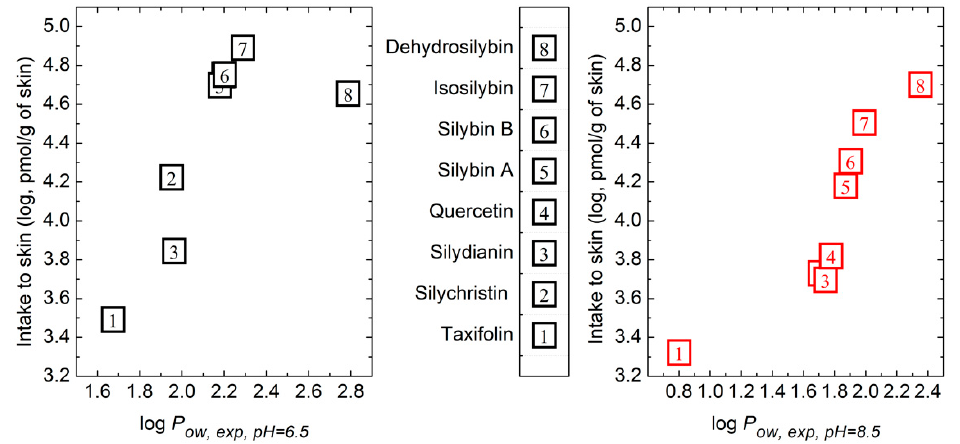
Figure 2. Relation of compounds’ skin intake to their lipophilicity. The relation of skin intake to experimental n -octanol/water partition coefficient (log P ow,exp ) at pH 6.5 is presented on the left; the relation of skin intake to log P ow,exp at pH 8.5 is shown on the right.